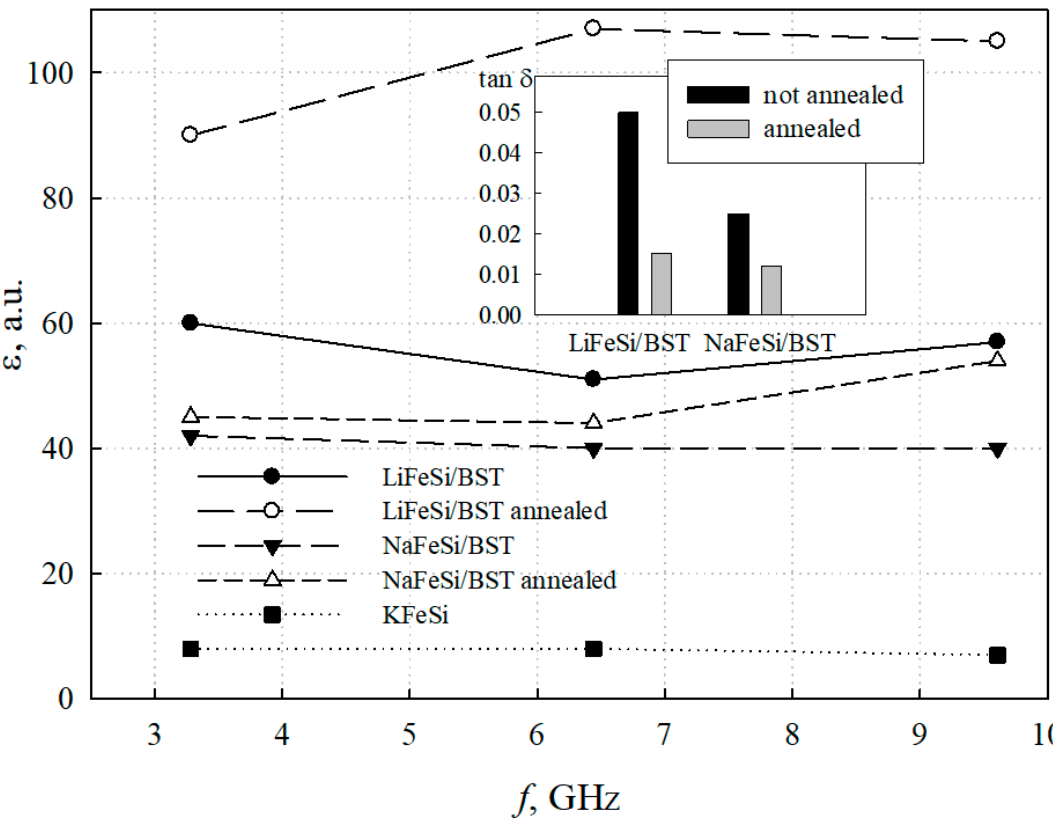
Figure 8. Dielectric permittivity of KFeSi base glass, and NaFeSi / BST and LiFeSi / BST glass-ceramic samples. The insert presents dielectric losses of NaFeSi / BST and LiFeSi / BST glass-ceramic samples before and after annealing in an oxygen atmosphere.